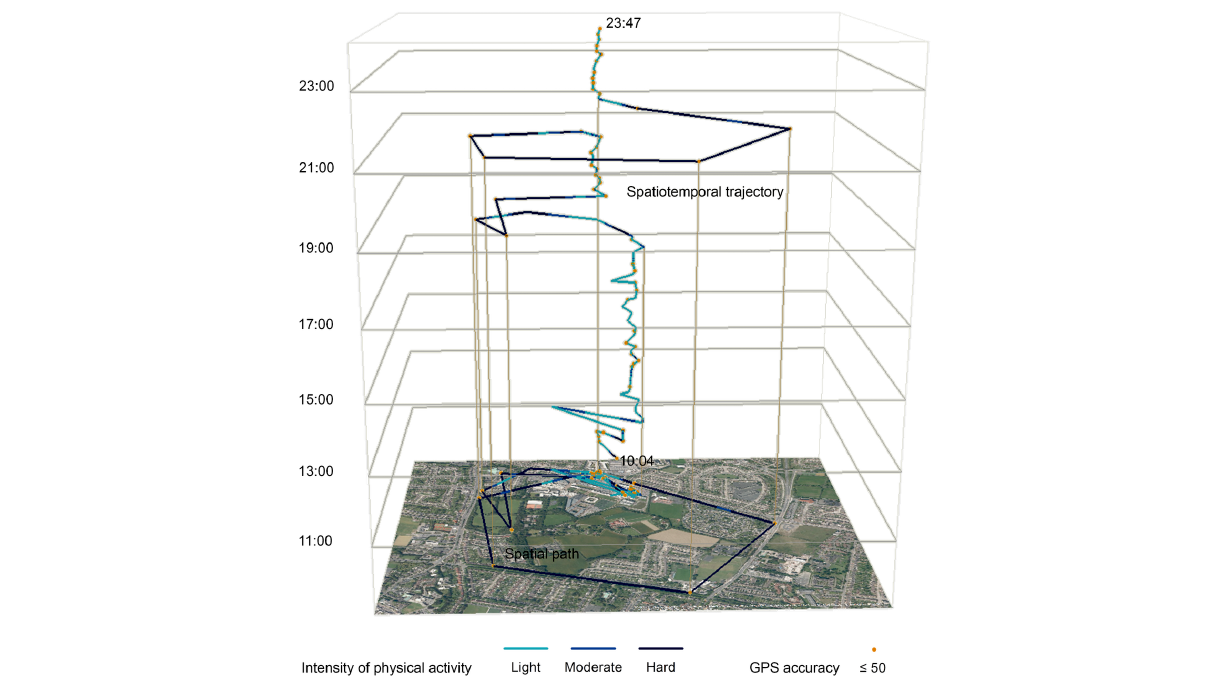
Figure 8. Detailed example of a participant’s daily movement. Position is depicted on the two-dimensional plane, and time is depicted on the vertical plane. Graduated shading of the movement path indicates activity level (dark shading=higher activity level). Orange point markers represent locations with an accuracy of >50